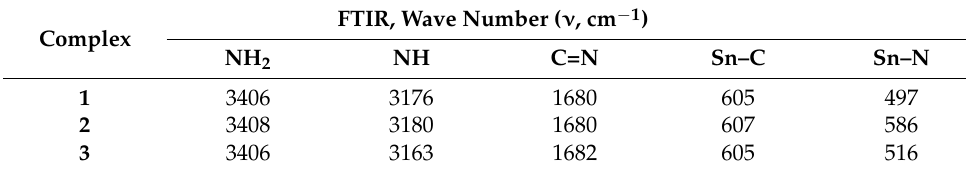
Table 2. FTIR spectral data for trimethoprim–tin complexes 1–3 .